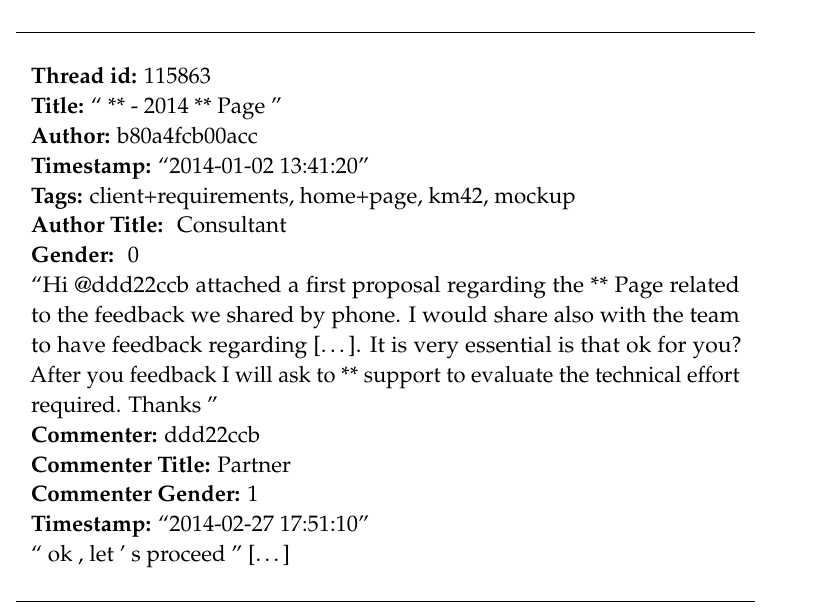
Figure 2. Example of an (anonymized)